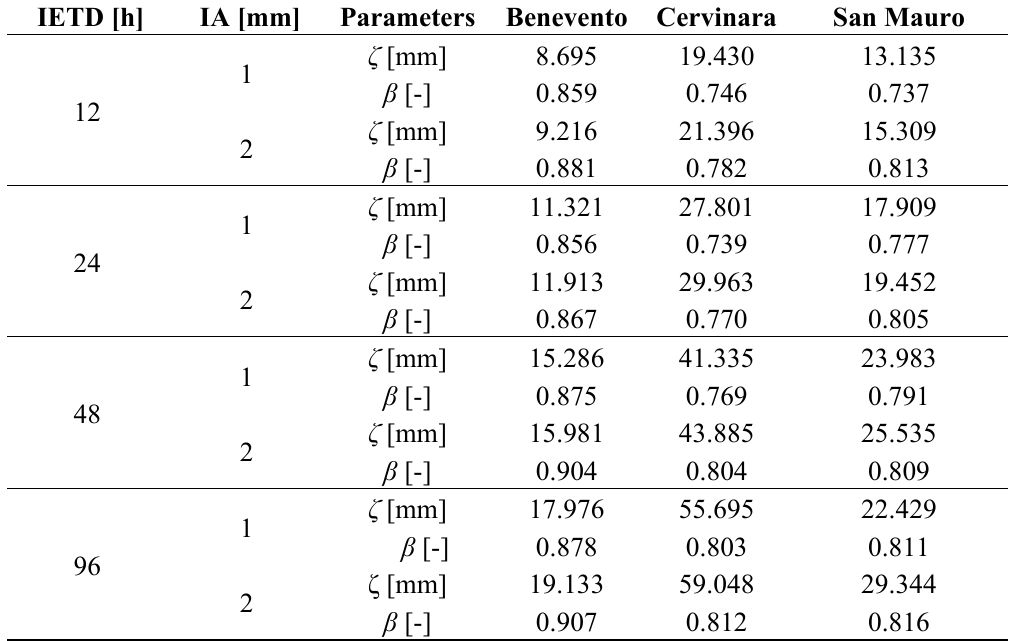
Table 3. Values of parameters ζ (mm) and β of the Weibull distribution, with